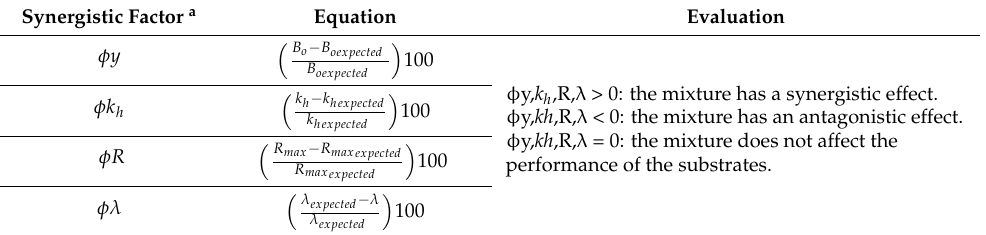
Table 4. Equations applied to evaluate the synergistic factors φ in AcoD of slaughterhouse wastewater streams and